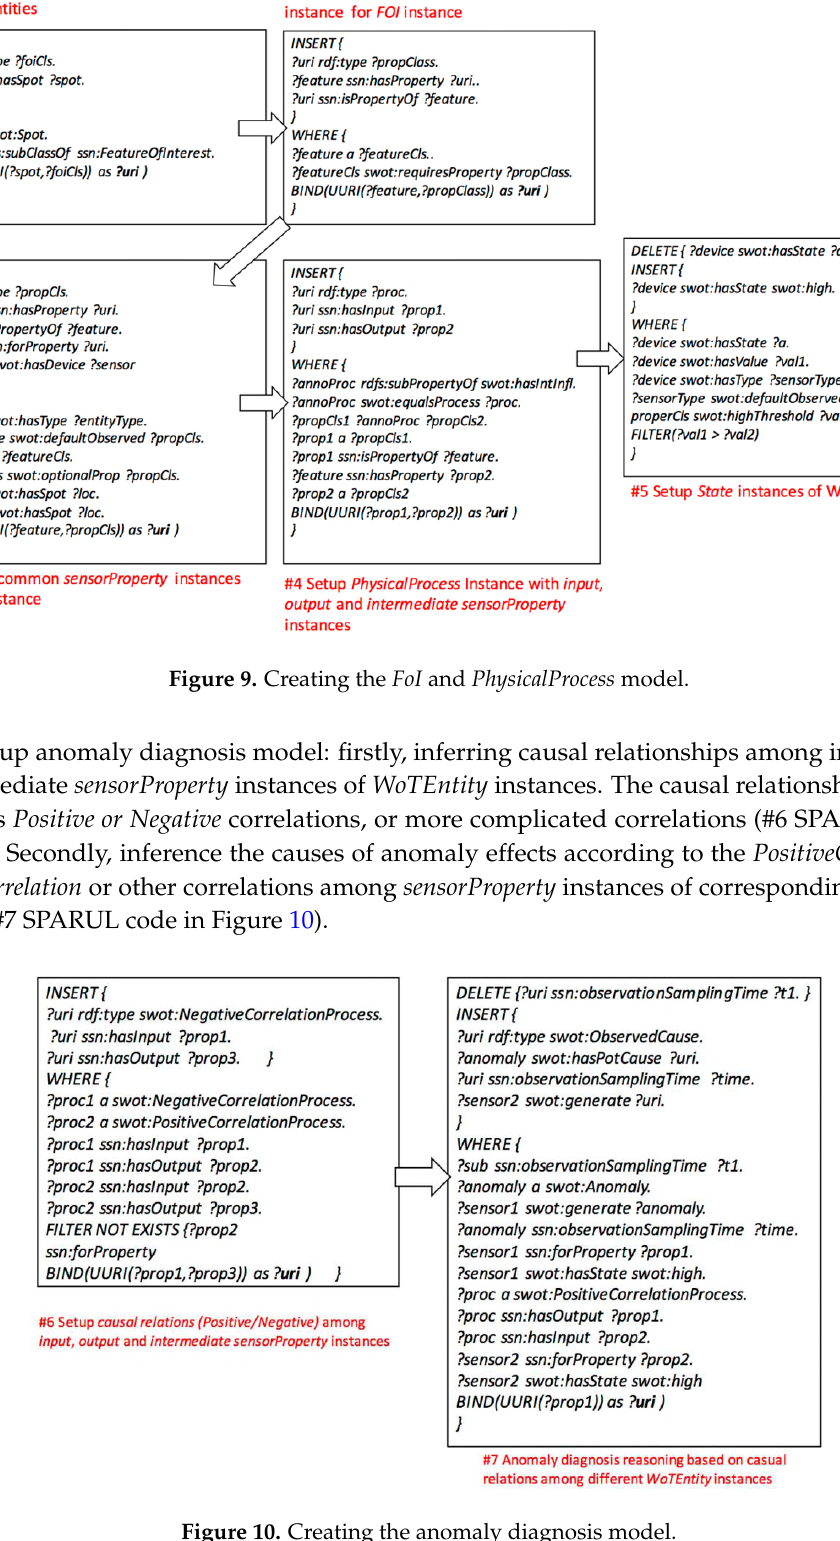
Figure 10. Creating the anomaly diagnosis model.